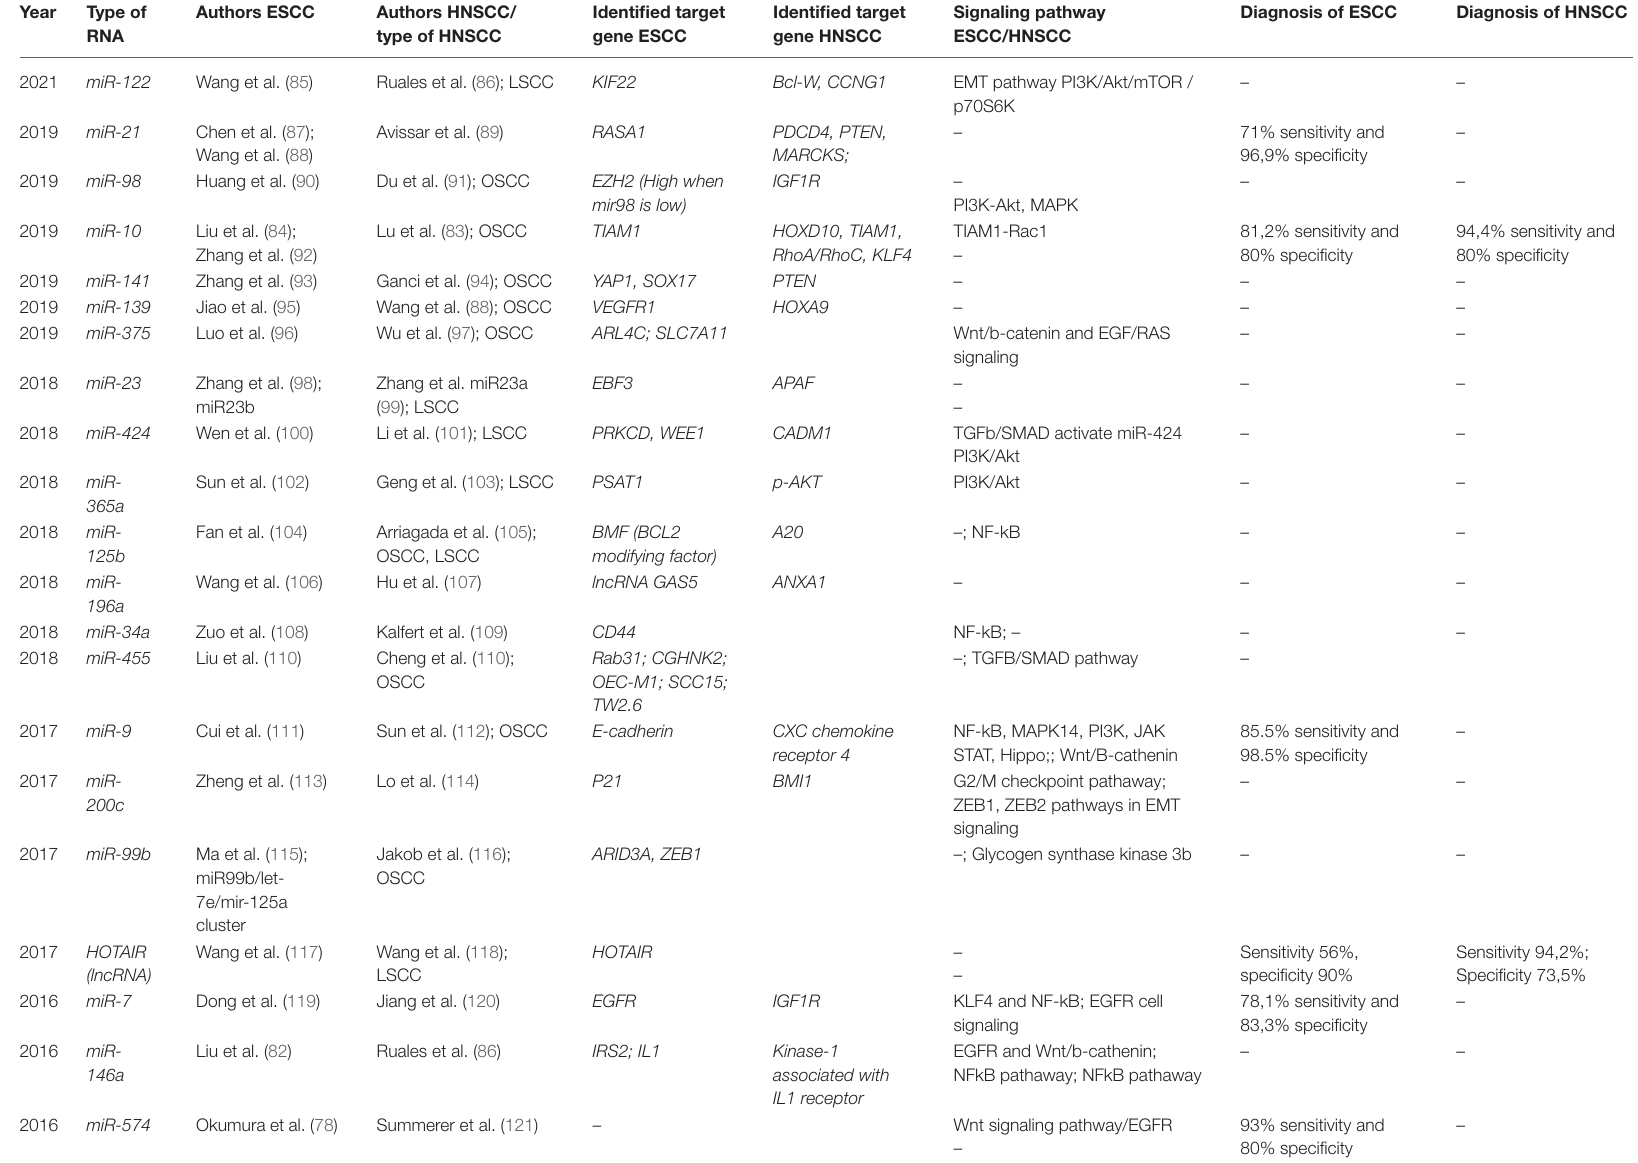
TABLE 4 | MicroRNA and lncRNA liquid biopsy studies in ESCC/HNSCC—targets and signaling pathways, and diagnostic